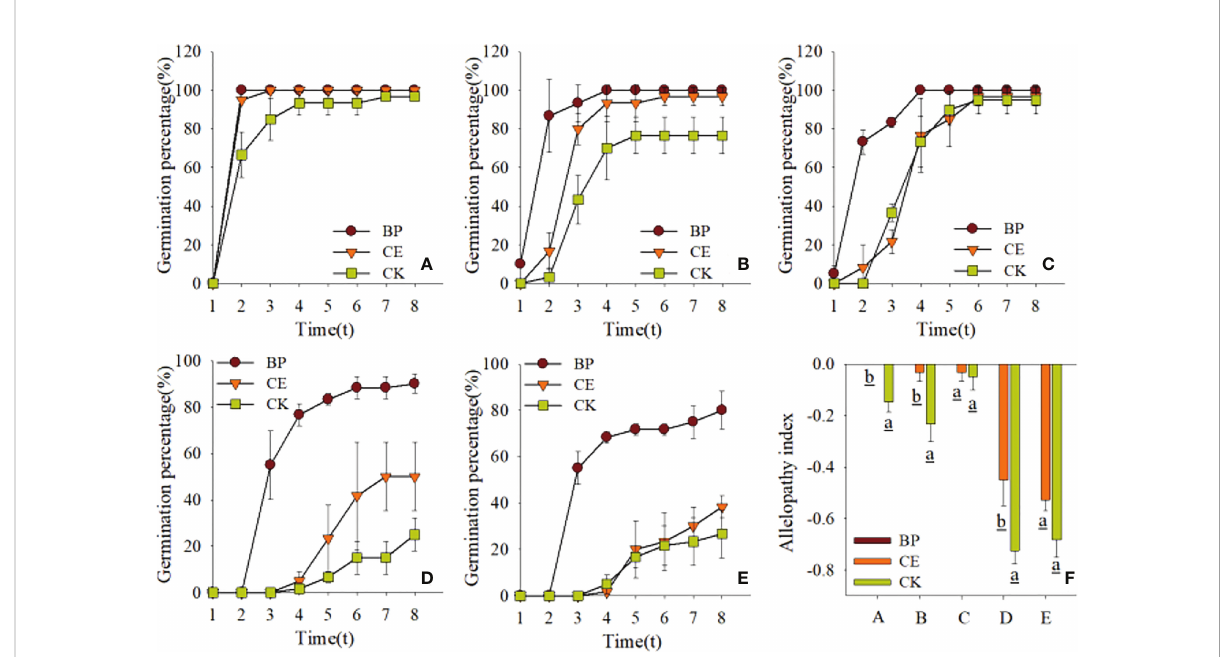
FIGURE 3 Effect of CE and CK root exudates on seed germination rate in recipient plants. (A – E) shows the effects of CE and CK root exudates on the seed germination rate of radish, cucumber, lettuce, pepper, and ryegrass respectively, and (F) shows the difference of allelopathic effects of CE and CK root exudates on the germination rate of the above receptor plants; (A – E) represent radish, cucumber, lettuce, pepper, and ryegrass respectively.